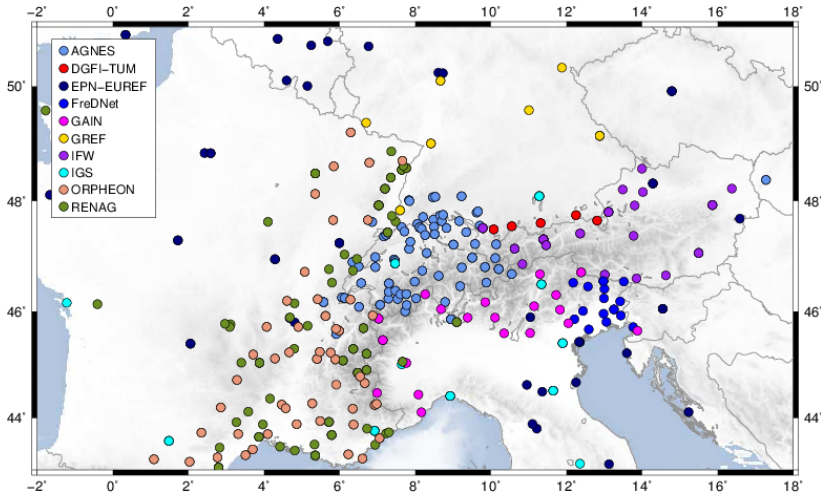
Figure 2. CO-GNSS stations processed for the estimation of the surface kinematics in the Alps. The stations of the contributing CO-GNSS arrays are colour coded. Topography and bathymetry after the ETOPO1 model (Amante and Eakins,